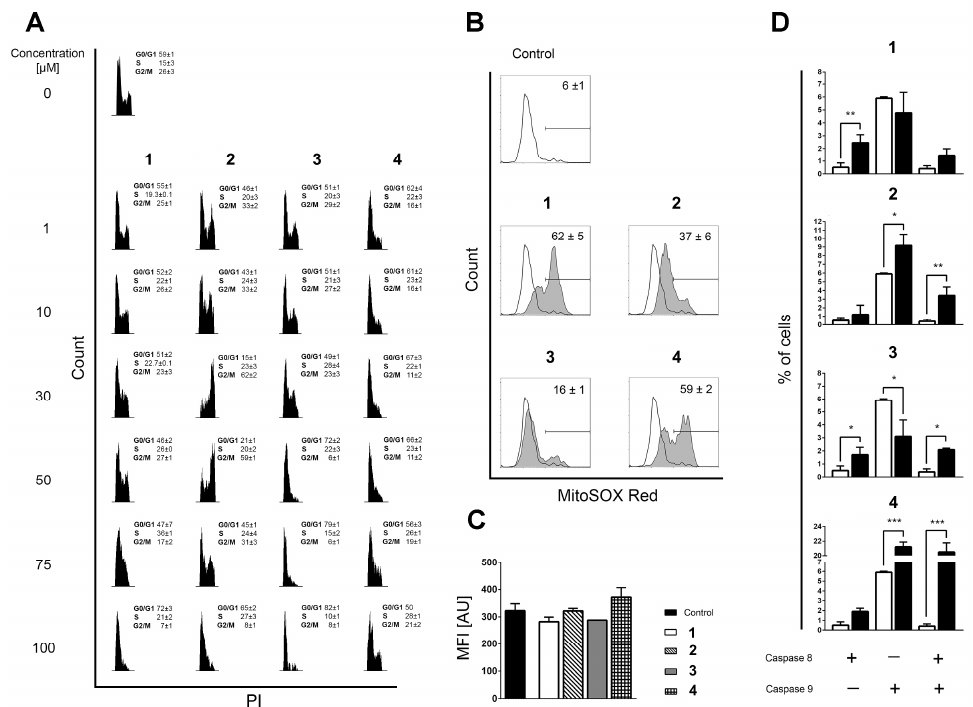
Figure 2. ( A ) Distribution of THP-1 cells within phases of mitotic division assessed on the remaining cells after Annexin V/PI readouts. Incidences of cells in phases G0/G1, S, and G2/M were determined according to the distribution of cells in nontreated populations. All results are expressed as mean ± SD of two replicates from independent experiments. ( B ) Mitochondrial superoxide (O 2 ●− ) generation in nontreated and cells treated with the investigated compounds, determined after 6 h of incubation by using MitoSOX Red staining. Results represent mean ± SD percentage of cells positive for mito- chondrial O 2 ●− production in three replicates from independent experiments. ( C ) Mean fluorescent intensity (MFI) computed for O 2 ●− -positive subpopulations, expressed in arbitrary units (AU). Re- sults are presented as the mean ± SD of three replicates from independent experiments. The Krus- kal–Wallis test showed no statistical difference in mitochondrial O 2 ●− accumulation between the an- alyzed samples. ( D ) Percentages of cells positive for activated caspase-8, caspase-9, or both caspases acquired in nontreated samples (open bars) or in samples treated for 6 h with the investigated com- pounds (closed bars). Bars represent the mean ± SD of three replicates from independent experi- ments. Statistical evaluation was performed using an unpaired t -test with Welch’s correction com- paring treated to non-treated populations. Significant differences are marked with *, **, and ***.